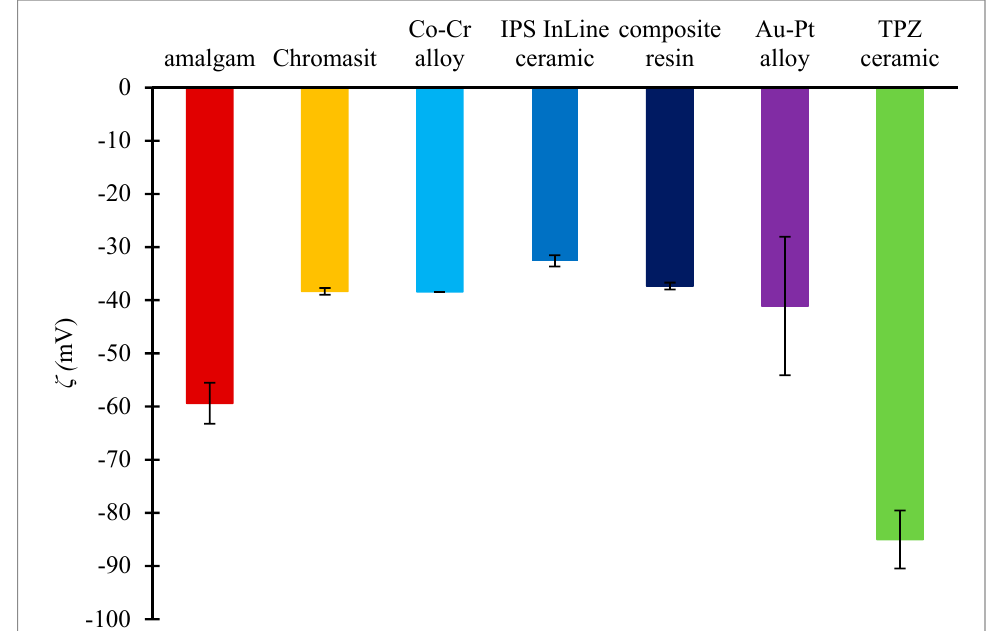
Figure 3. Zeta potentials of seven dental surfaces: amalgam, Chromasit, Co-Cr alloy, IPS InLine ceramic, resin-based composite, Au-Pt alloy, and TPZ ceramic.